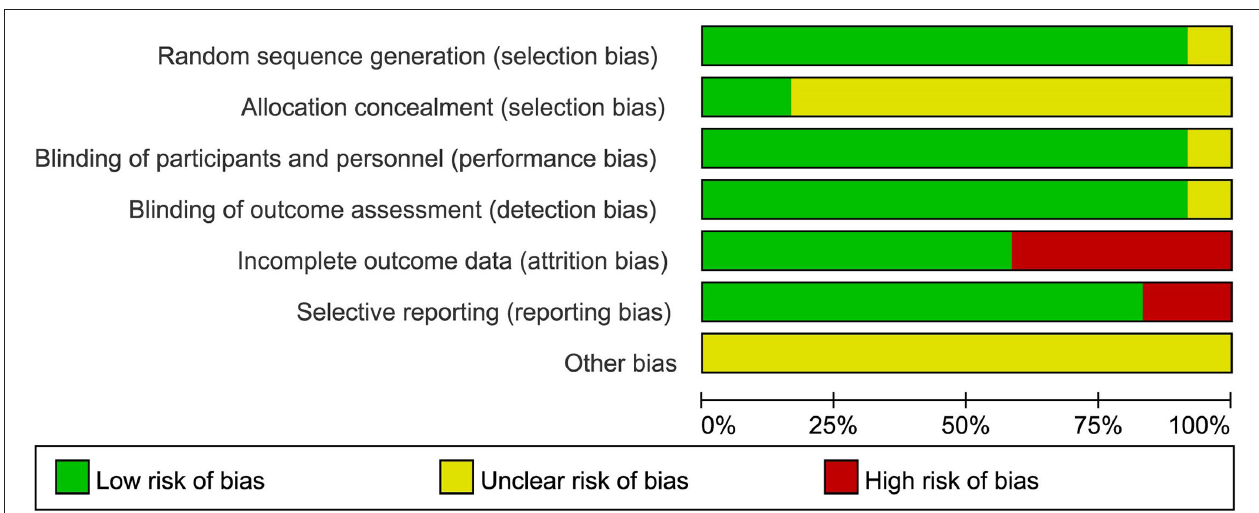
FIGURE 3 | Risk of bias graph: the risks of bias of included studies. Based on the Cochrane’s handbook.